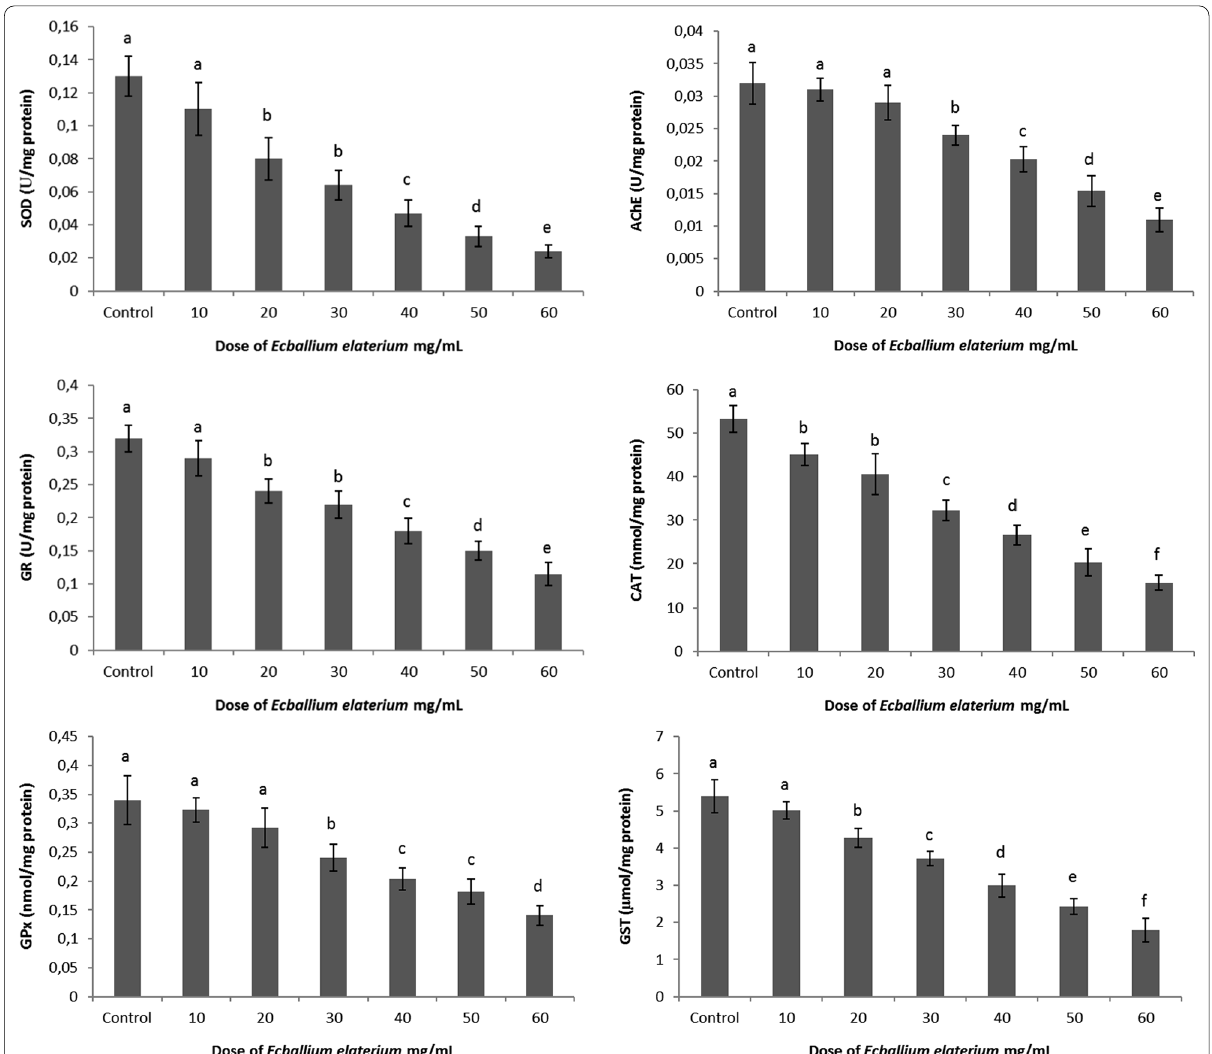
Fig. 3 Effect of E. elaterium fruit juice doses on enzyme activities of G. mellonella larvae. *Letters above bars indicate significant differences between concentrations. Bars with the same letter are not significantly different. Error bars indicate standard deviation (SD) of